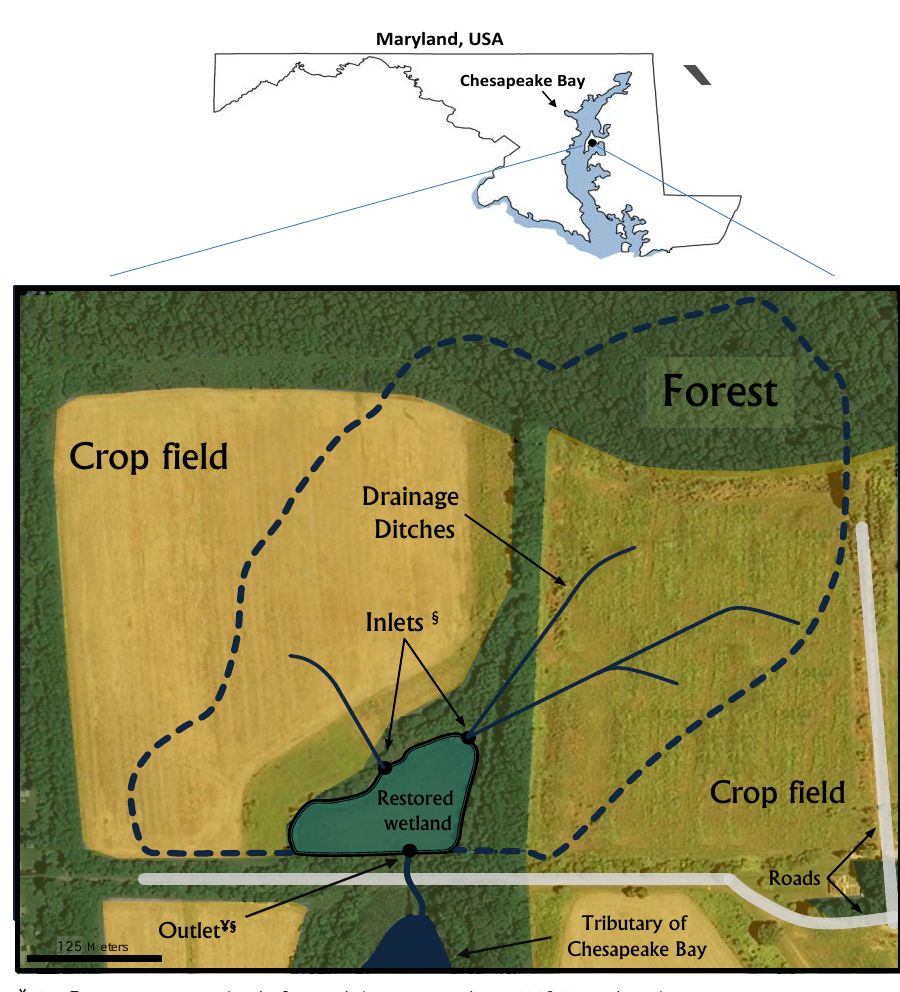
Figure 4. Study wetland located on Kent Island, MD. The watershed draining to the wetland is outlined by dashed lines (adopted from Sharifi, et al. [15]).